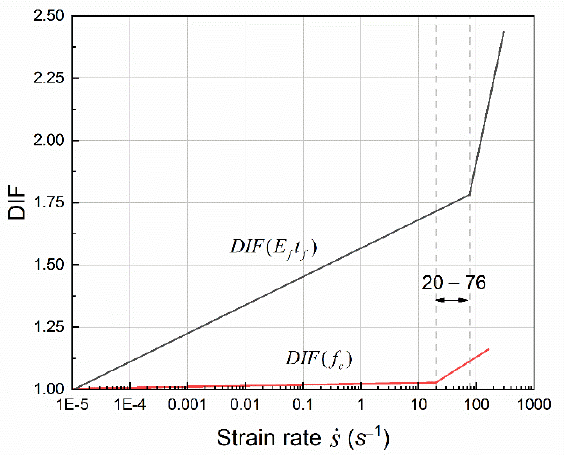
Figure 26. The dynamic enhancement laws of FRP stiffness and brick strength.